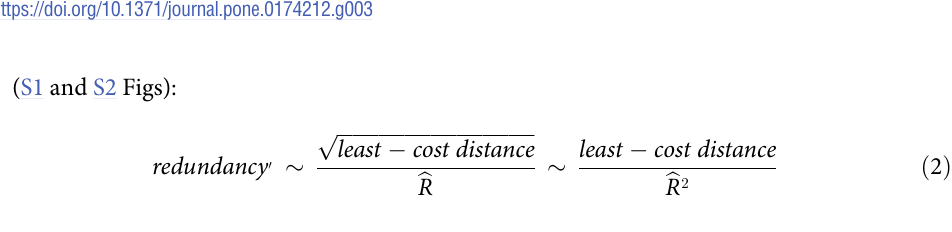
(S1 and S2 Figs): ffiffiffiffiffiffiffiffiffiffiffiffiffiffiffiffiffiffiffiffiffiffiffiffiffiffiffiffiffiffiffiffiffiffiffiffiffiffi p least (cid:0) cost distance least (cid:0) cost distance (cid:24) redundancy 0 (cid:24) b R b R 2 where redundancy’ is the linearized version of redundancy after transforming least-cost or resis- tance distance. In any case, these methods produce somewhat the same rank order (S3 Fig), but